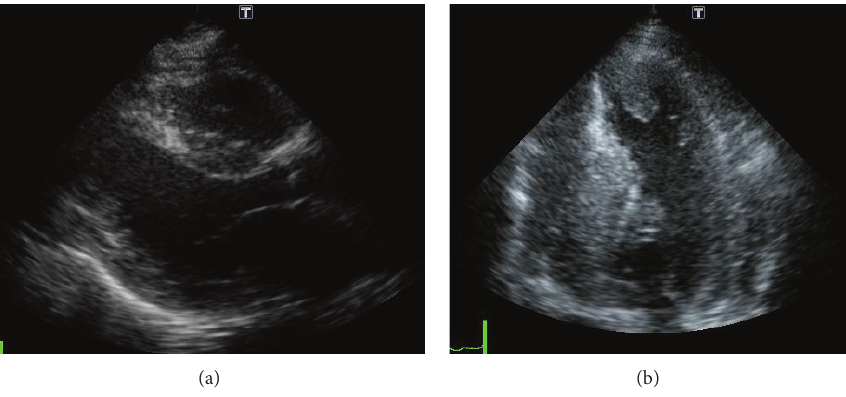
Figure 2: Parasternal long-axial view (a) and four-chamber view (b) of the transthoracic echocardiography showing asymmetrical hypertrophy and a thin-walled apical aneurysm with thrombus.